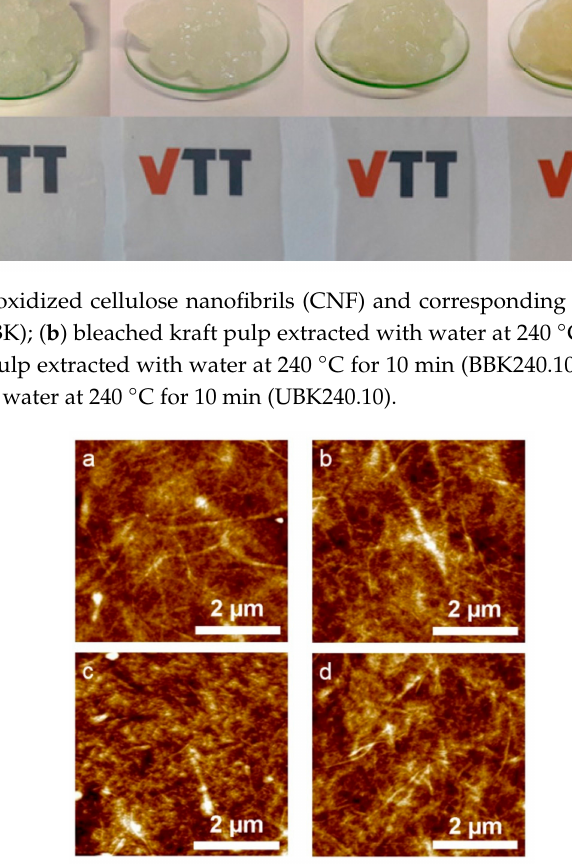
Figure 2. Atomic force microscope (AFM) height micrographs (5 × 5 µ m 2 ) of CNF samples obtained after TEMPO oxidation and microfluidization of: ( a ) bleached birch kraft pulp (BBK); ( b ) bleached kraft pulp extracted with water at 240 ◦ C for 2 min (BBK240.2); ( c ) bleached kraft pulp extracted with water at 240 ◦ C for 10 min (BBK240.10); ( d ) unbleached kraft pulp extracted with water at 240 ◦ C for 10 min (UBK240.10).